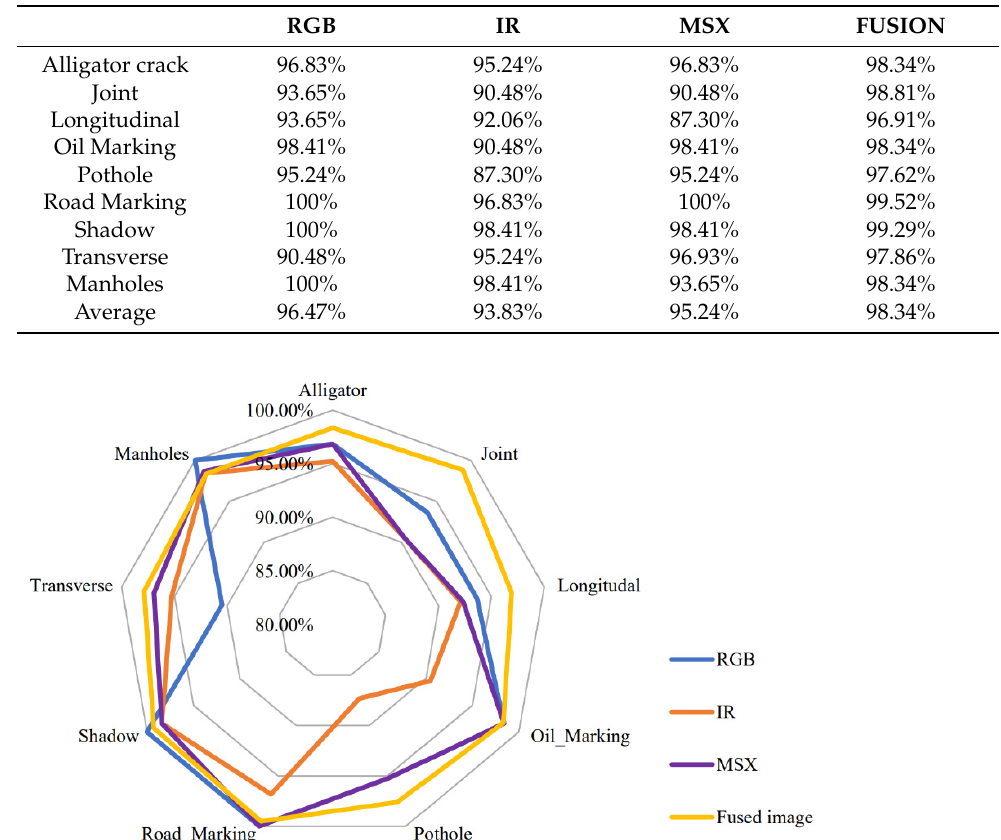
Table 5. Comparison of performance of different input data for each class.